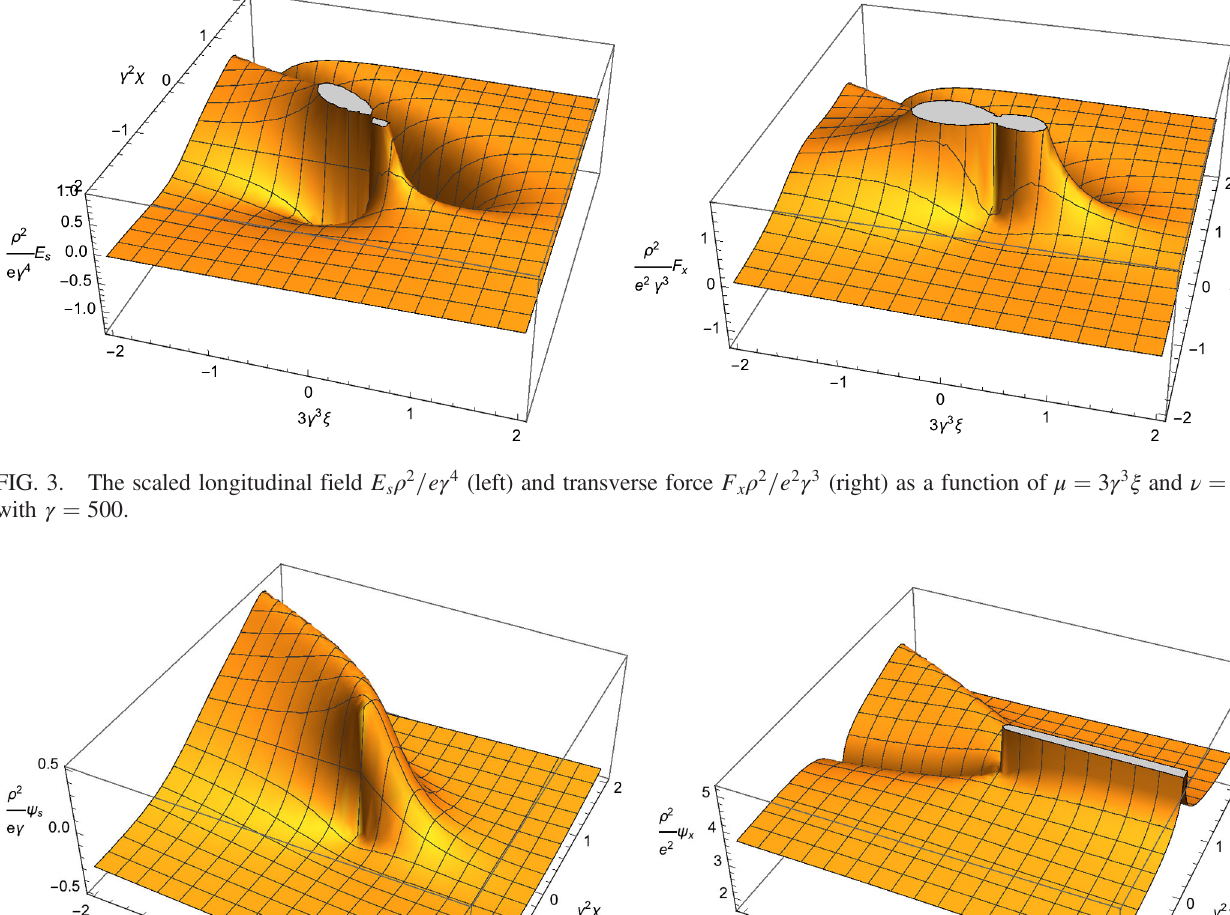
ρ 2 =e γ 4 (left) and transverse force F s